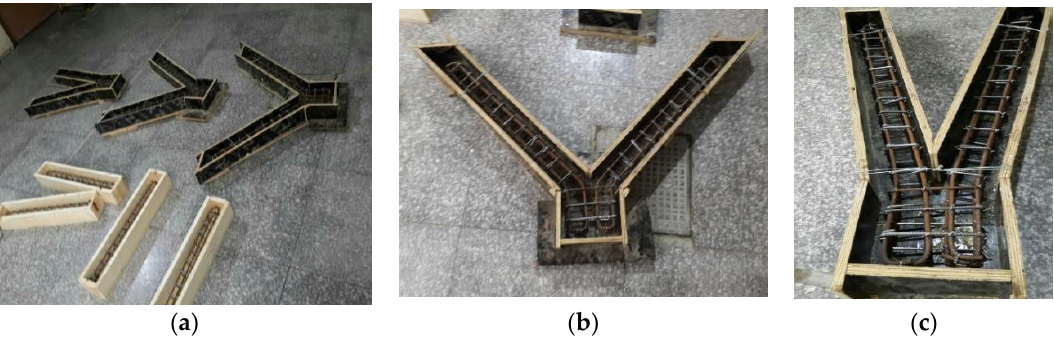
Figure 4. ( a ) All models, ( b , c ) details of reinforcement and details of